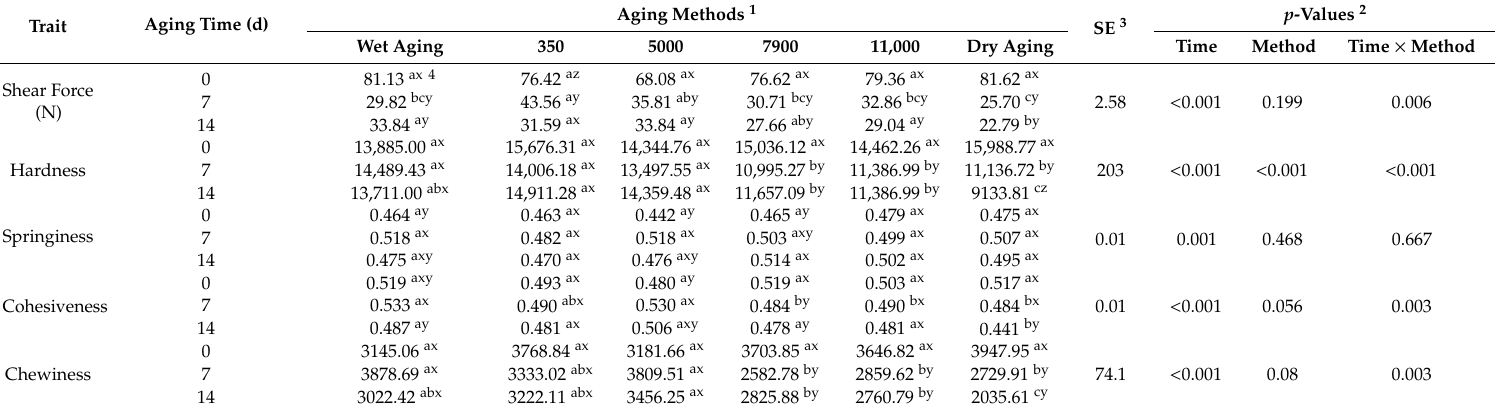
Table 3. E ff ects of di ff erent aging methods and aging time on the shear force and texture profile analysis (TPA) of beef.